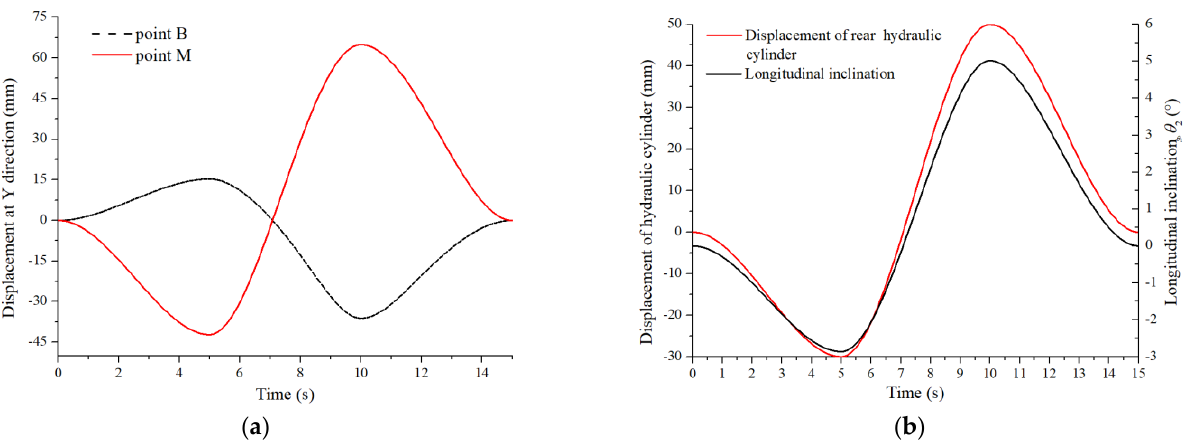
Figure 10. Simulation results of longitudinal tilting adjustment when the vehicle is in the lowest: ( a ) Displacement curve of the hinge point in the Y-direction. ( b ) Hydraulic cylinder displacement and lateral inclination θ 2 .